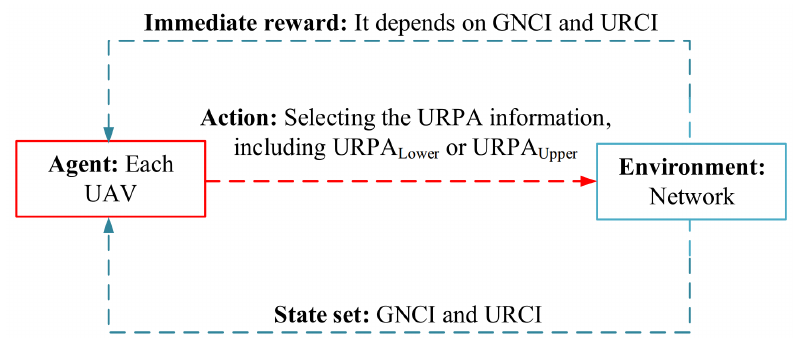
Figure 16. Learning structure in